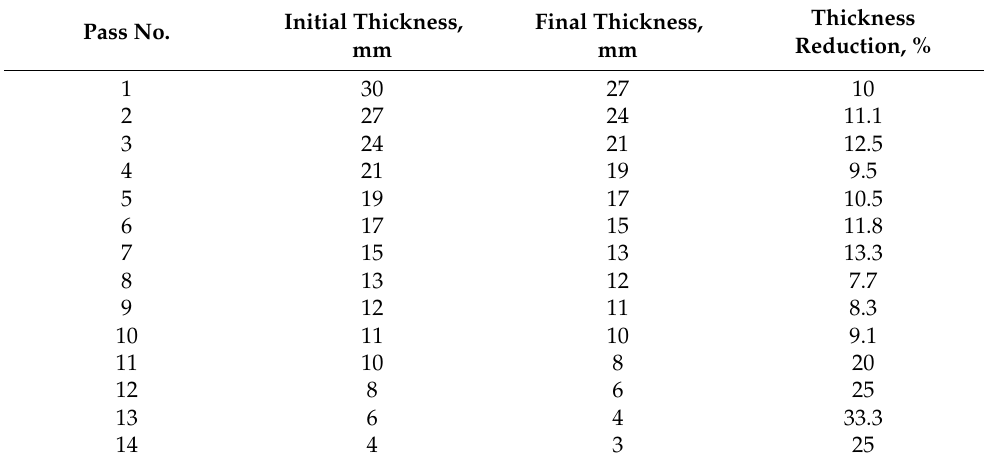
Table 2. Ingot hot rolling